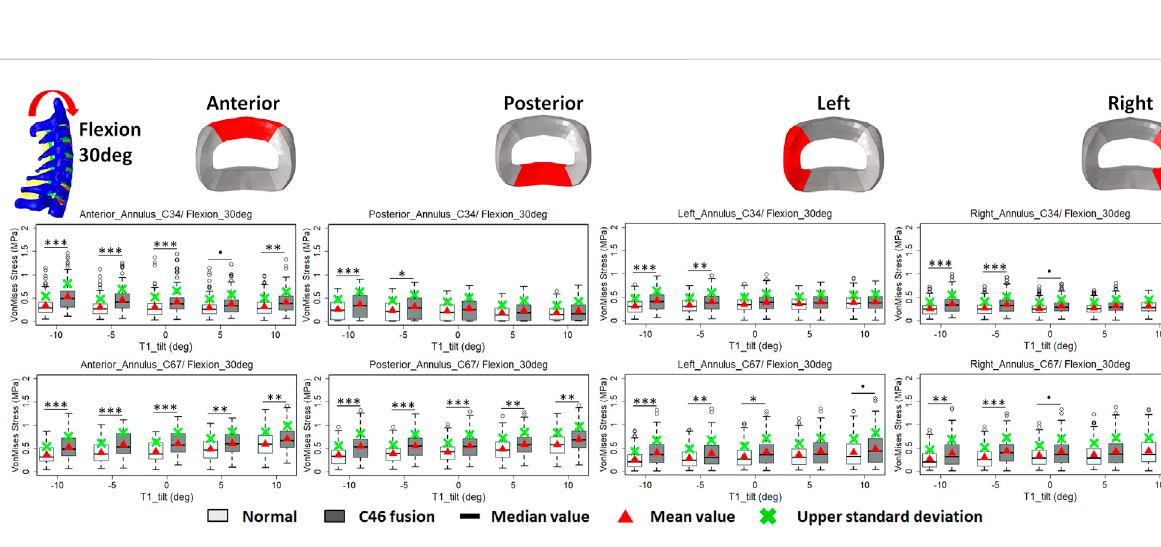
Frontiers in Bioengineering and